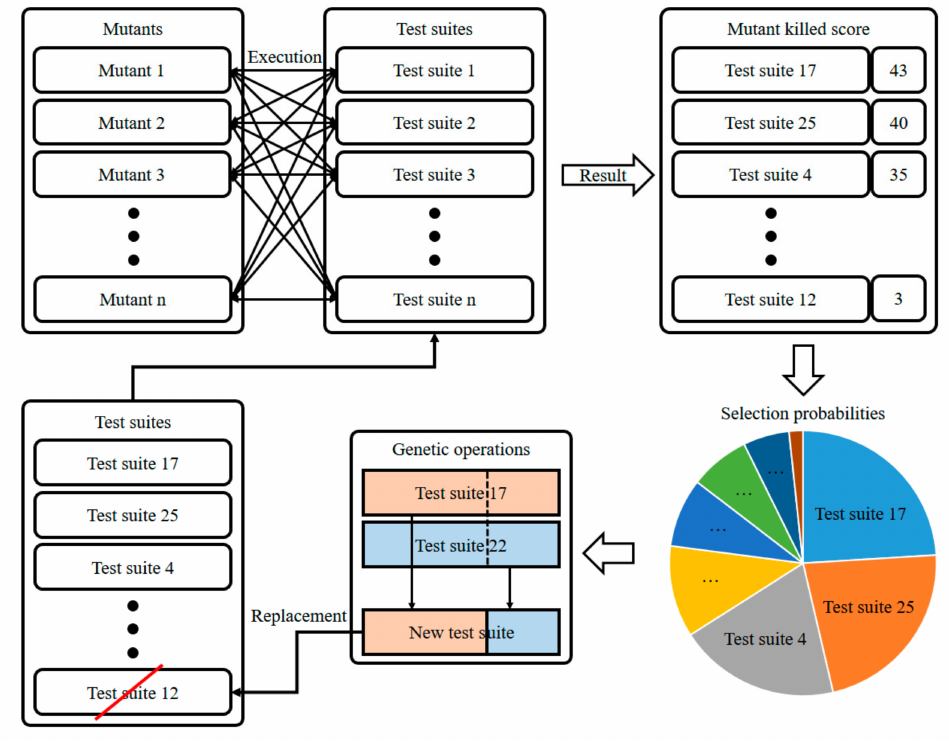
Figure 1. An example of search-based mutation